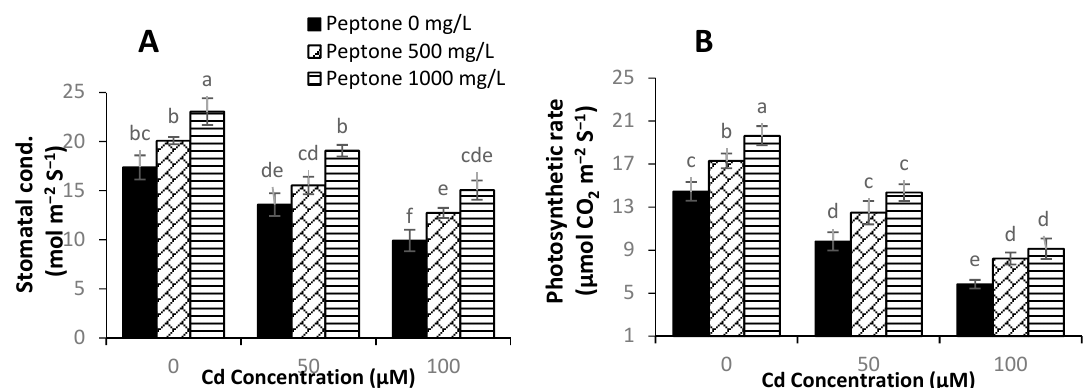
Figure 3. The influence of the foliar application of peptone (0, 500, and 1000 mgL − 1 ) on the stomatal conductance ( A ) and photosynthetic rate ( B ) of spinach plants grown under Cd stress. Values represent the means of four replicates with standard deviations. Letters on the bar indicate the significant differences between given treatments at p < 0.05.